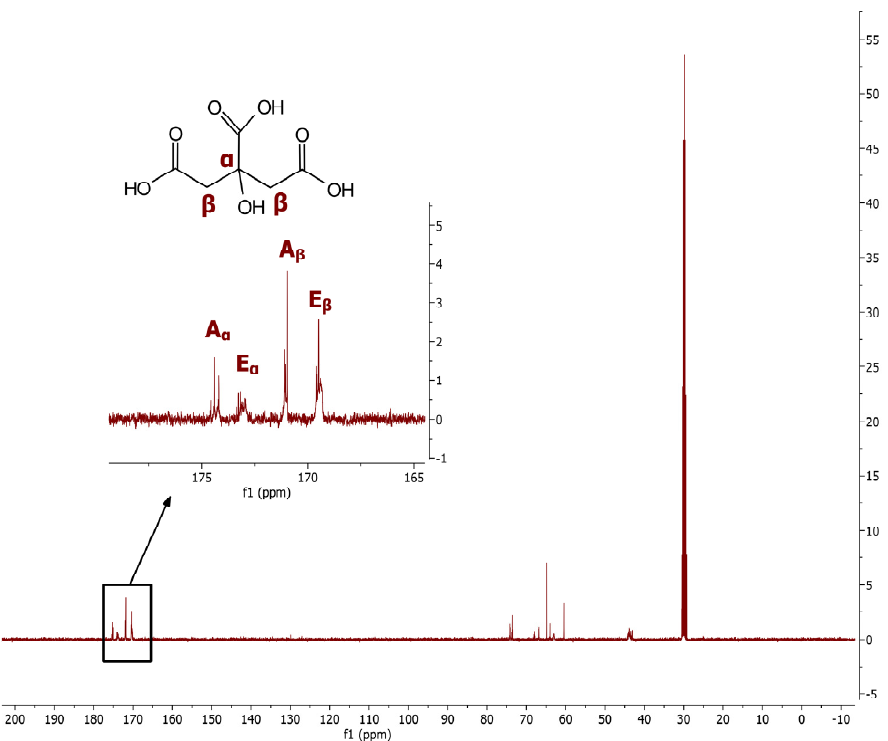
Figure 2. 13 C − NOE NMR spectrum of poly(1,2-ethanediol citrate). Additionally, the characteristic peaks in the range δ 125– δ 130 ppm were noticed for some polyester samples synthesized with a catalyst content exceeding 1% of the citric acid mass content (Figure 3). The discussed relationship was also apparent in the slightly yellow color of these samples. In conclusion, the increase in the catalyst content apparently promotes dehydration.